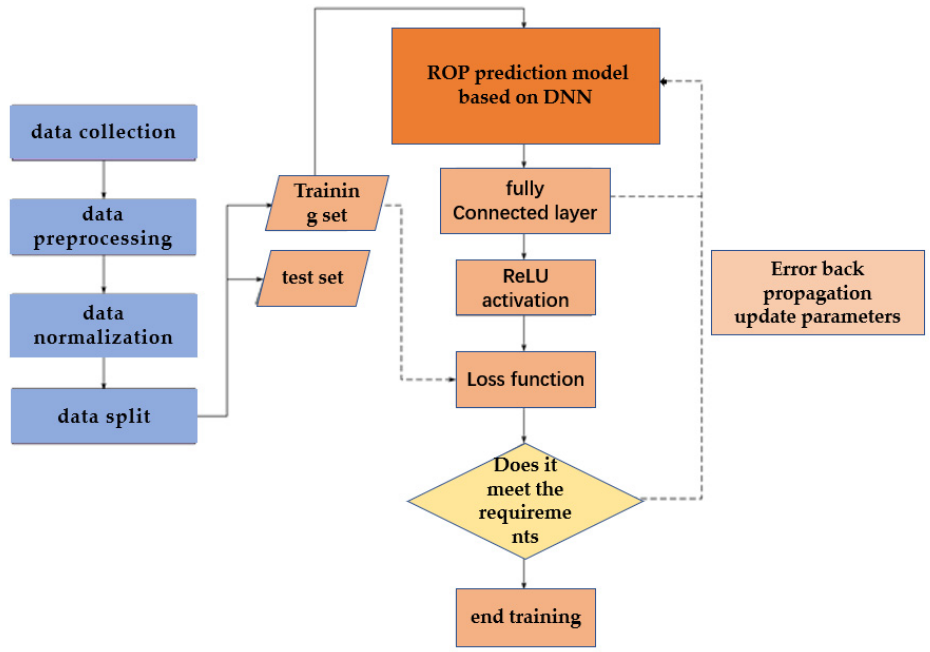
Figure 16. ROP training process.